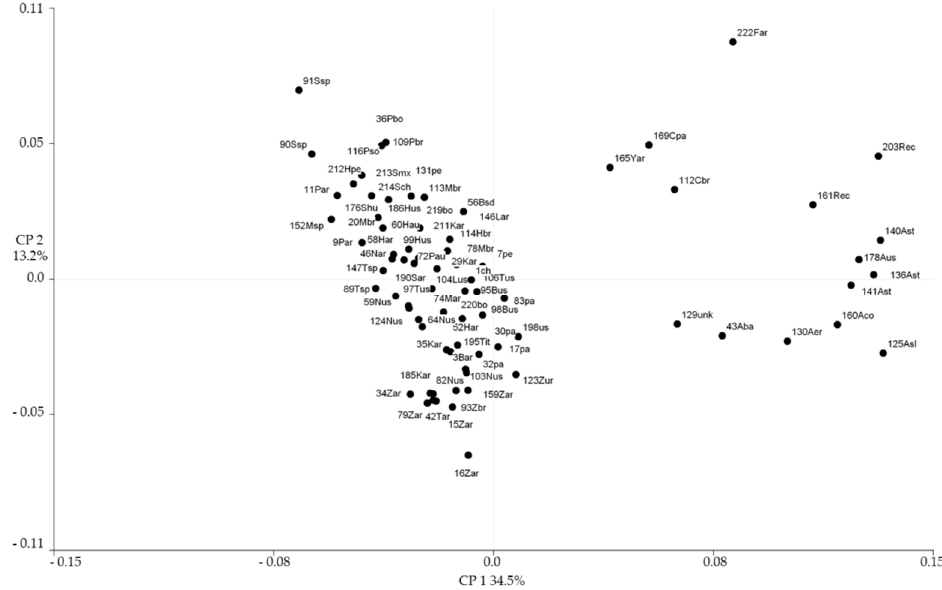
Figure 18. Procrustes analysis biplot for morphological and molecular data of 159 accessions of C. maxima and out-group species. Codes are the same as in Figure 15.